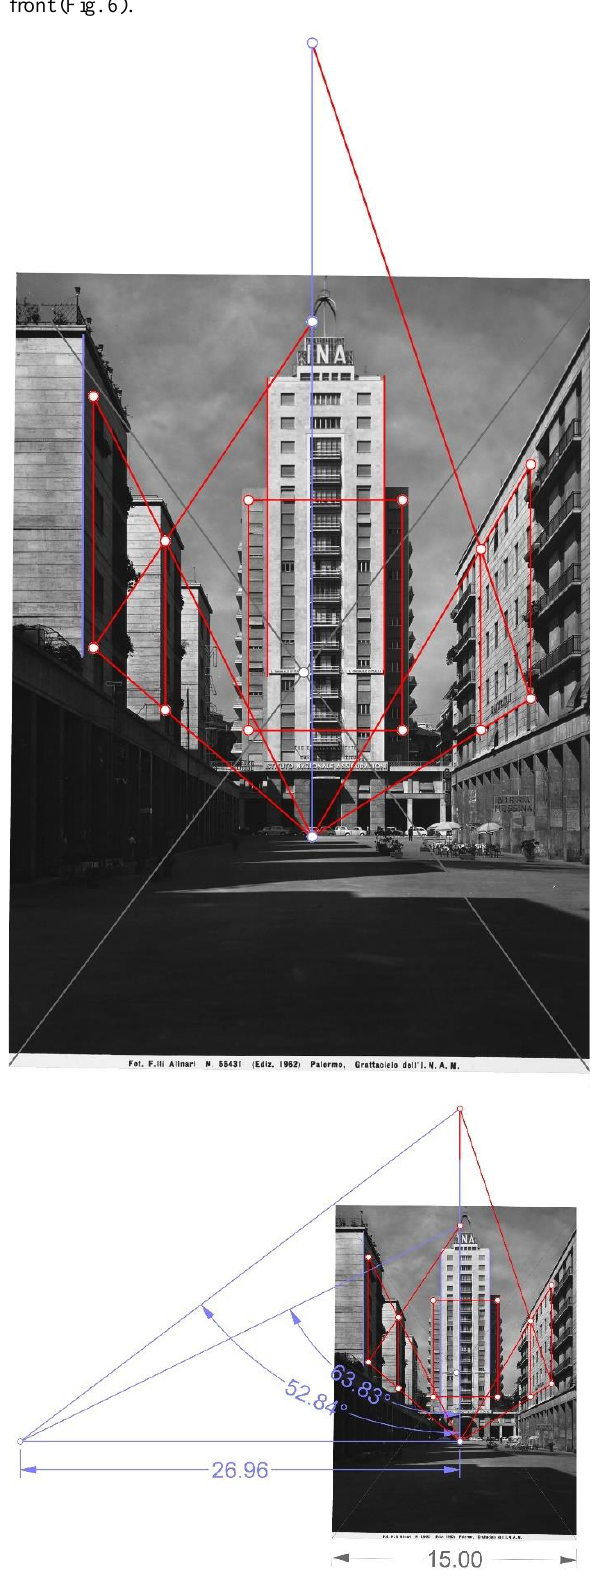
Figure 7: Photo Alinari with the rectangles highlighted (above); perspective reconstruction of the inner orientation (below).